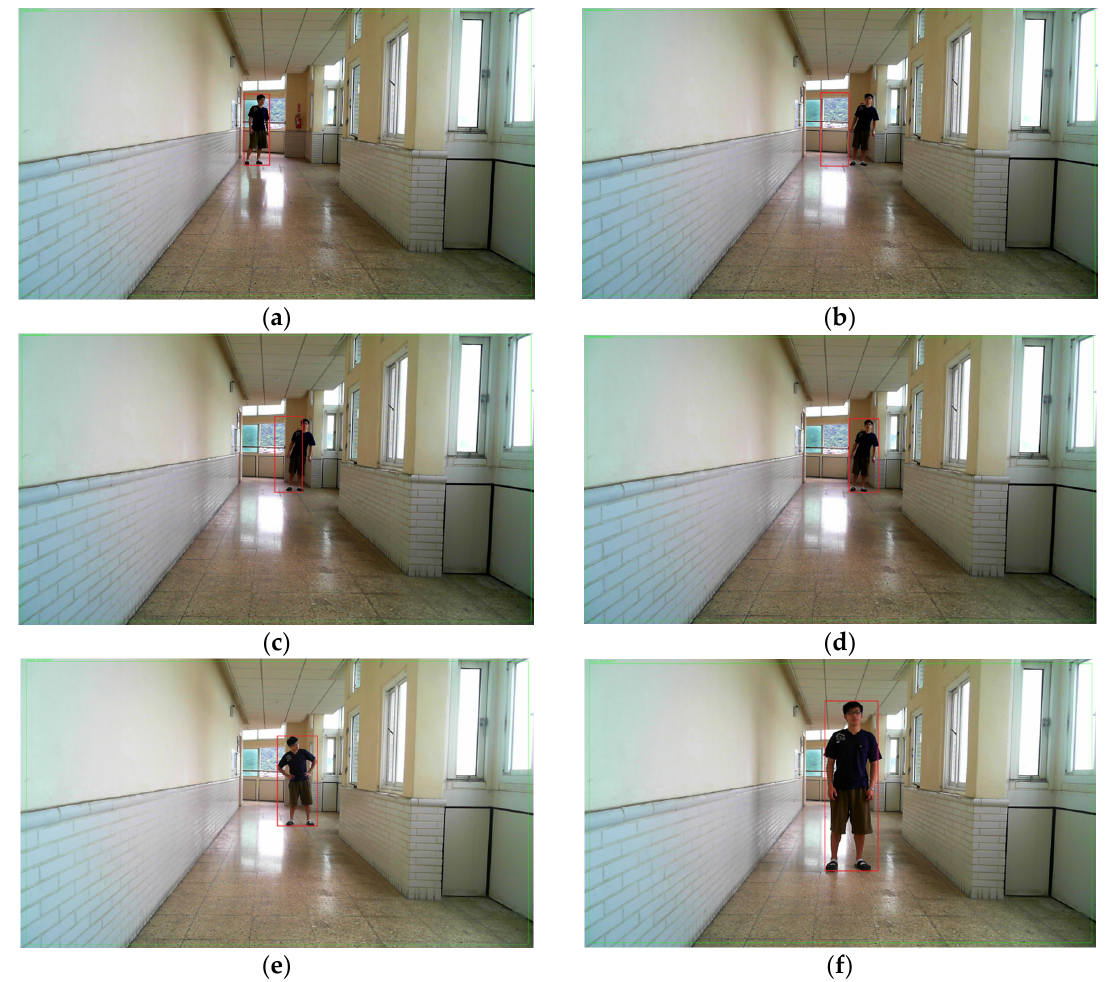
Figure 7. Steps for mean shift tracking process against a static background: ( a ) Find the object; ( b ) the object moves to the right side; ( c ) search high color density; ( d ) catch the object; ( e ) the object moves forward; ( f ) keep tracking the object.